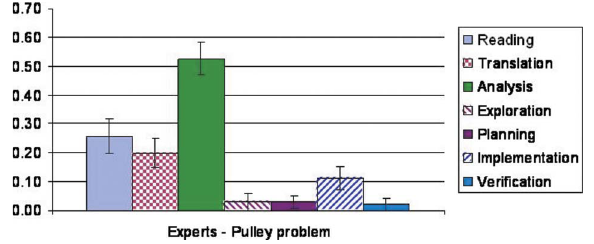
FIG. 12. (cid:1) Color online (cid:2) Distribution of time spent in by experts during their solutions to the more challenging pulley problem. The distribution is similar to the expert distribution in the electrostatics problems of